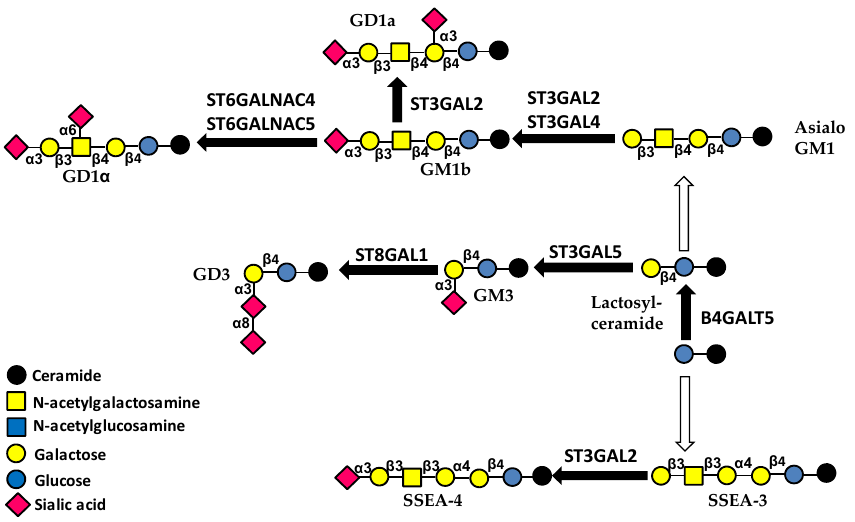
Figure 4. Pathways of glycolipid biosynthesis. Black arrows indicate single-step reactions. White arrows indicate that the indicated transition is the product of multiple steps. Enzymes catalyzing the same reactions but not mentioned in the text are not shown.